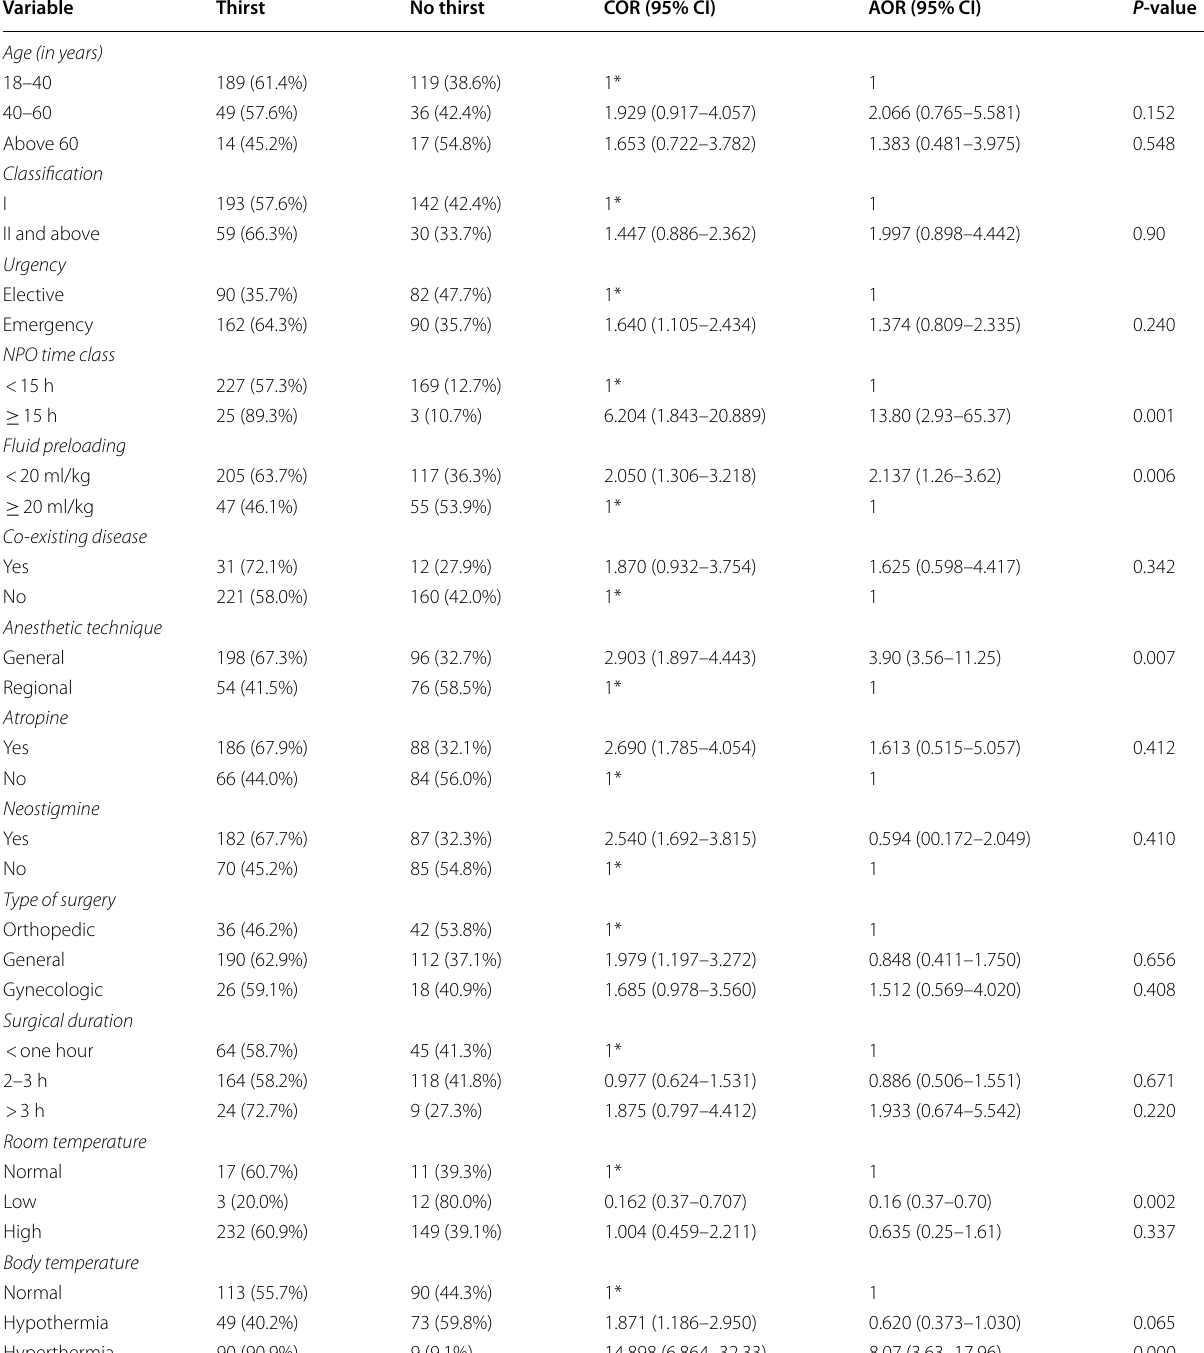
Table 4 Factors associated with prevalence of postoperative thirst at post anesthesia care unit